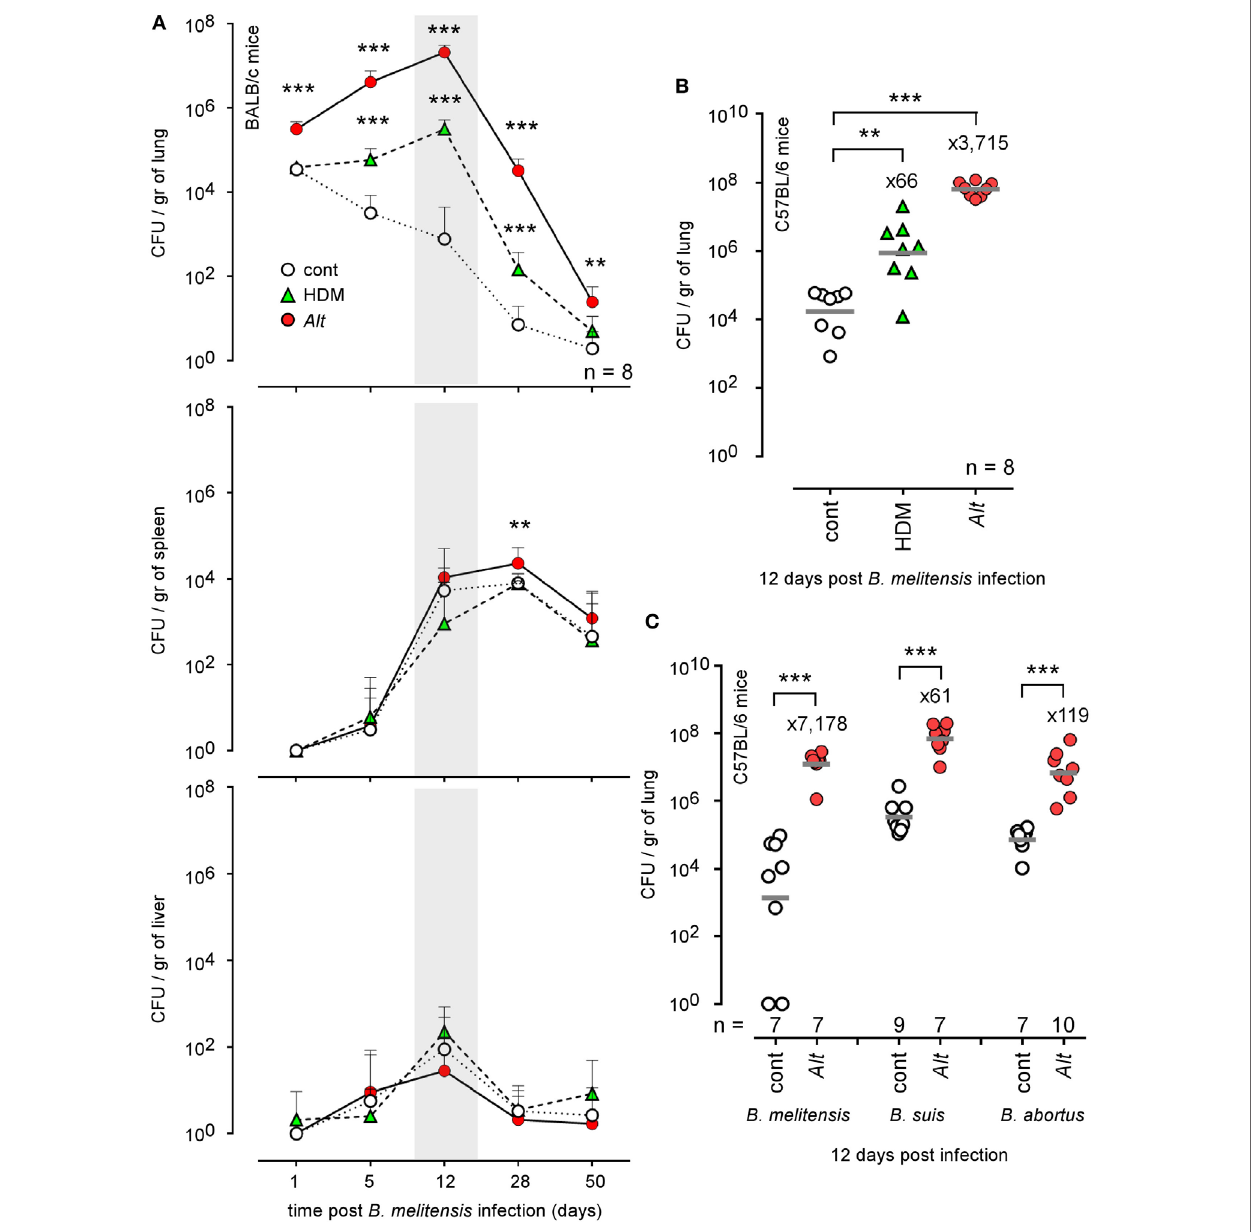
FigUre 1 | Impact of allergic asthma sensitization on the course of Brucella infection in wild-type mice. Wild-type BALB/c and C57BL/6 mice received repeated i.n. administration of phosphate-buffered saline, HDM, or Alt before i.n. infection with 2 × 10 4 CFU of mCherry- Brucella melitensis (a,B) or 2 × 10 3 CFU of B. melitensis, B. abortus , or Brucella suis (c) , as indicated in the figure and in the Section “Materials and Methods.” The mice were sacrificed at the selected time post infection. The data represent the number of CFU/gr of lung, spleen, and liver. n denotes the number of mice used for each lineage. These results are representative of at least two independent experiments. ** p < 0.01, *** p <